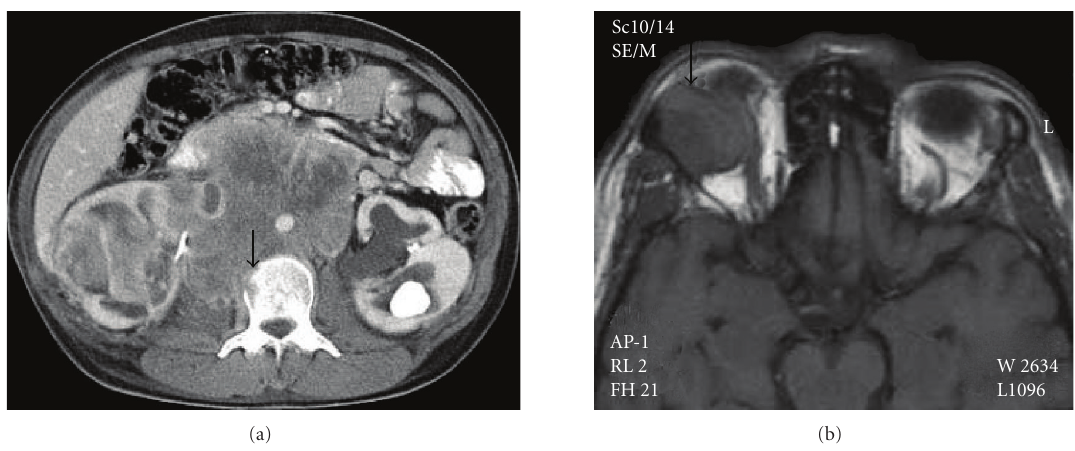
Figure 1: (a) CT of the retroperitoneal mass. Note the vertebral body invasion (arrow). CT: Computerized tomography. (b) T1-weighted MRI scans of the right orbital mass (arrow). MRI: Magnetic resonance imaging.